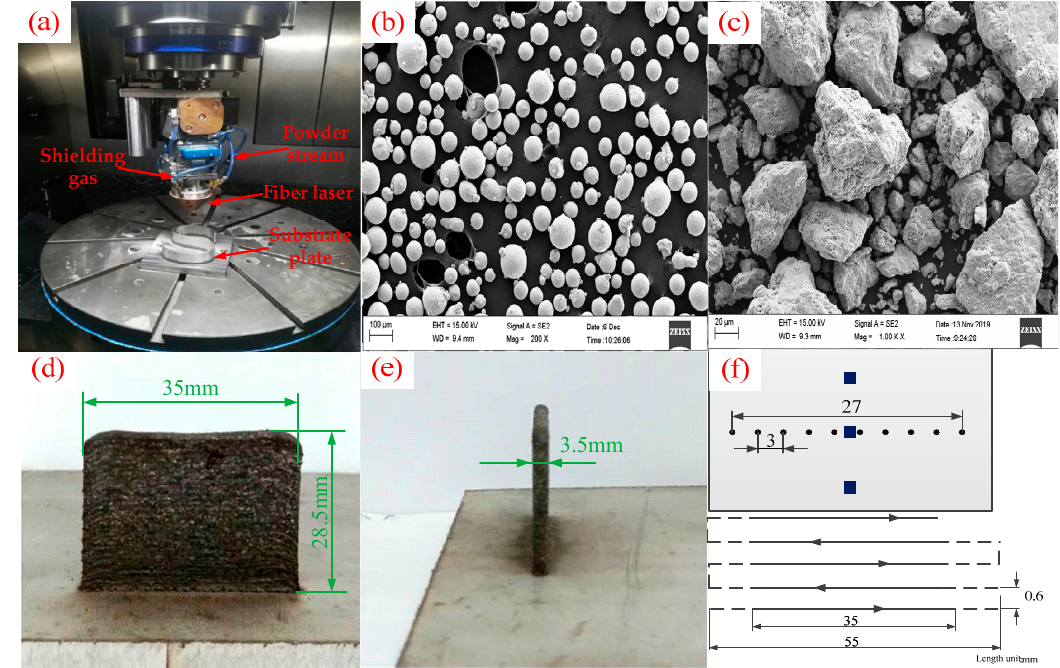
Figure 3. Experimental apparatus: ( a ) laser cladding system, ( b ) morphology of IN718 alloy powder (200 × ), ( c ) morphology of V powder (1000 × ), ( d ) main view of the sample, ( e ) left view of the sample, ( f ) Vickers hardness measurement points; secondary dendrite spacing (SDS), primary dendrite spacing (PDS), and diameter of equiaxed dendrites (DED), measurements locations and scan pattern. Table 1. Processing parameters of laser cladding.